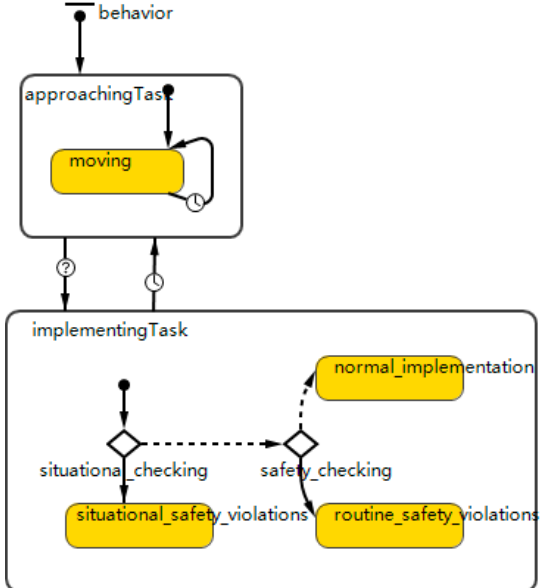
Figure 3. State chart for representing the decision rules of safety violations.